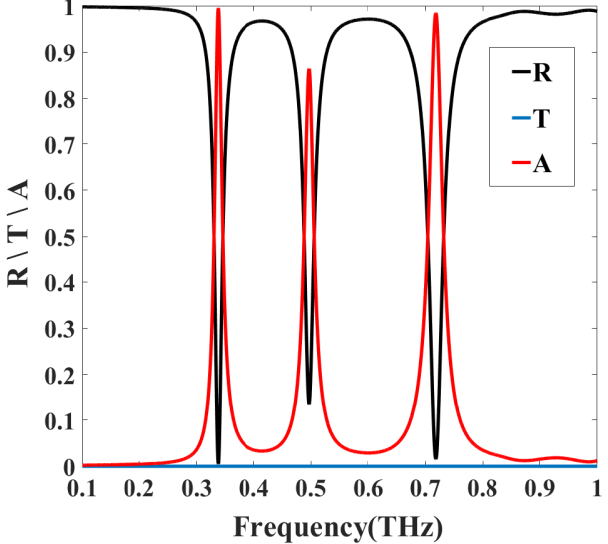
Figure 3. Simulated absorption, reflection, and transmission spectra of the absorber.